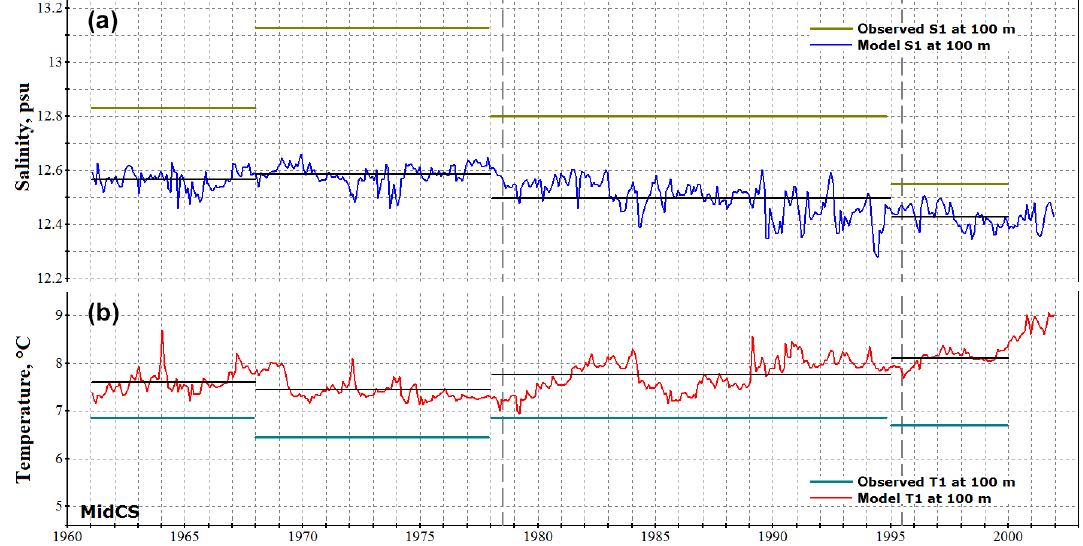
Figure 6. Salinity (a) and temperature (b) at 100m of depth at location 1 (MidCS; see Fig. 1) obtained in the model and those observed. The observational data are plotted as a mean value that is constant for four different periods. Mean model values for the corresponding periods are shown in thin black lines.